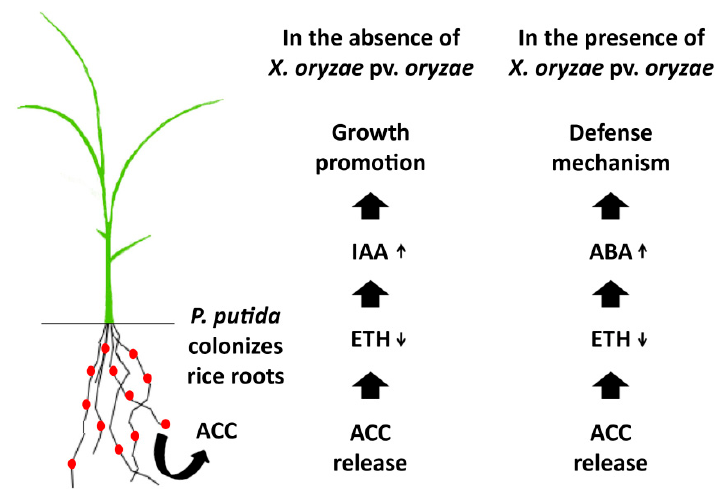
Figure 5. Proposed interaction mechanisms between P. putida and rice plants in the presence and in the absence of pathogen infection at the early rhizobacteria–plant interaction stages.